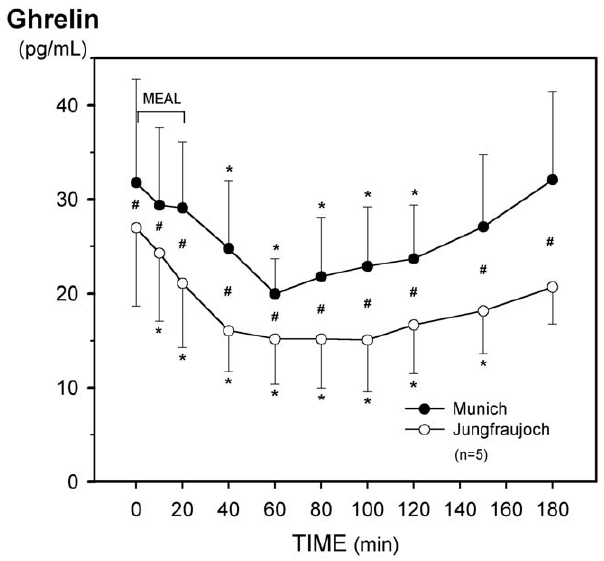
Figure 6. Effect of acute exposure to high altitude (Munich, 490 m, to Jungfraujoch, 3454 m) on postprandial plasma levels of ghrelin. Asterisks (*) indicate a significant decrease (p , 0.03) as compared with the preprandial values at 0 min and crosses ( # ) mean a significant (p , 0.03) difference between the respective values at the two sea levels.